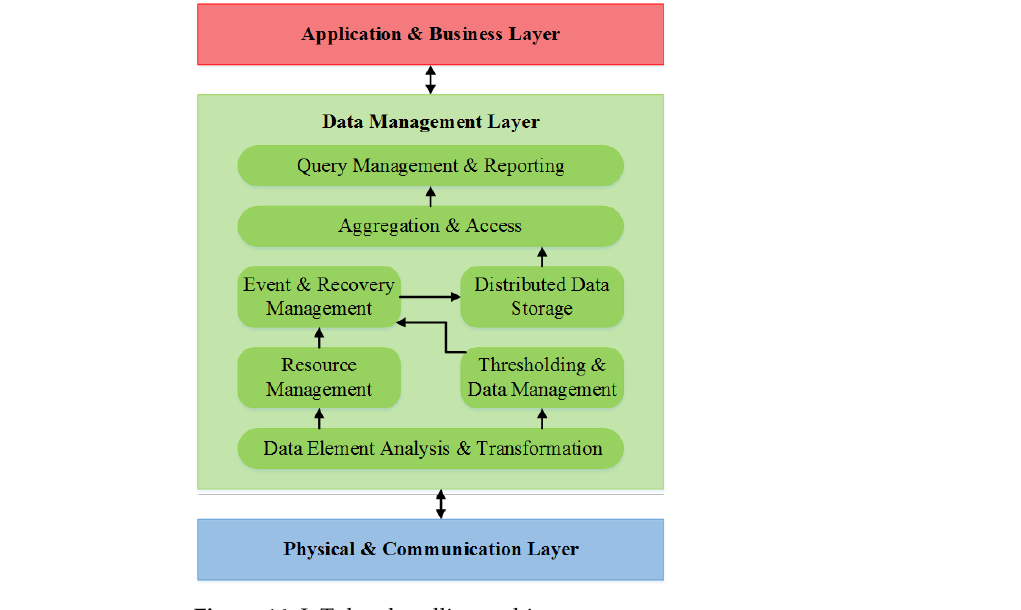
Figure 16. IoT data handling architecture. Table 4. IoT protocols and respective